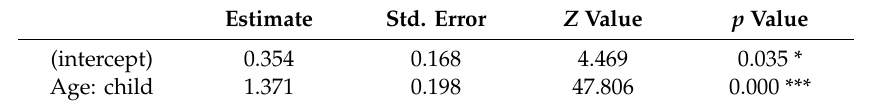
Table 2. Effects of age on the choice of “old-new” versus “new-old” order in children and adults. Estimate Std. Error Z Value p Value